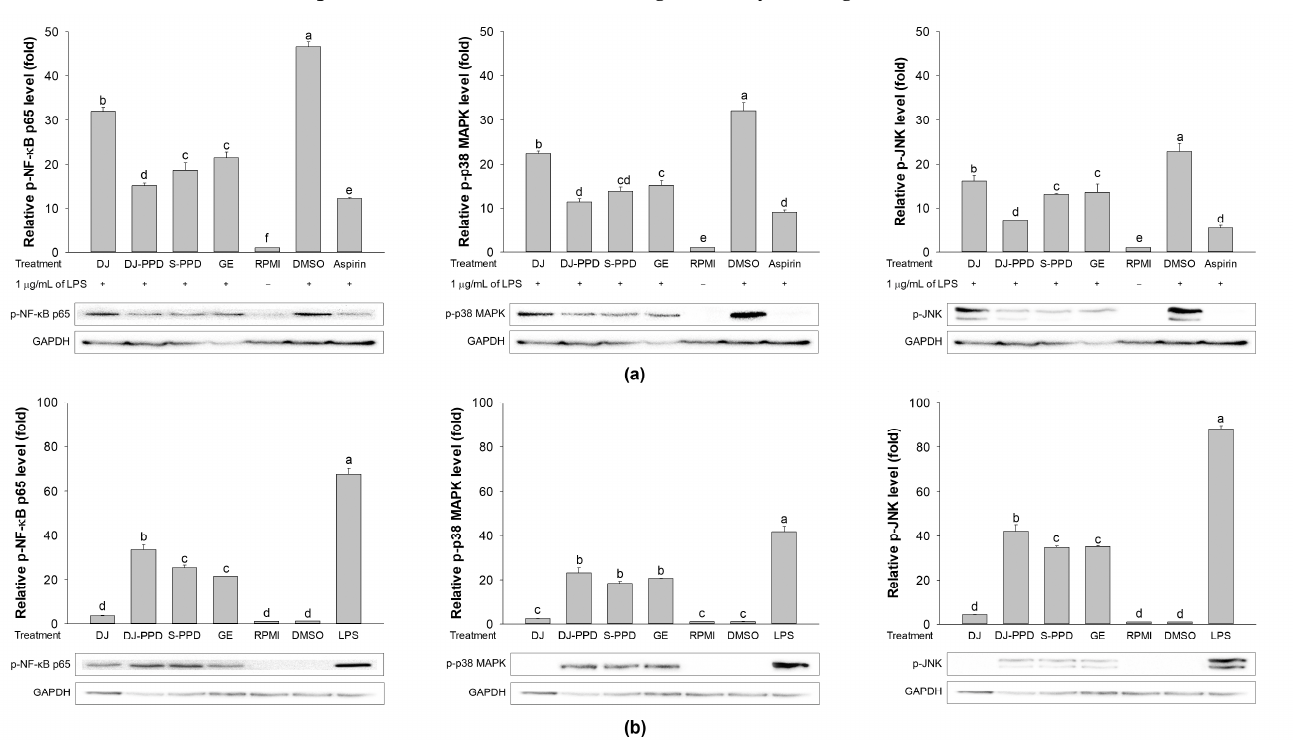
Figure 7. The immune-related pathway activation, ( a ) downregulation in cells pretreated with DJ extract, DJ-PPD extract, S-PPD, and GE extract, together with LPS stimulation, and ( b ) upregulation in cells pretreated with DJ extract, DJ-PPD extract, S-PPD, and GE extract. DJ, DJ-PPD, and GE con- centrations were 100 µg/mL, whereas the S-PPD concentration was 700 pg/mL. DMSO and LPS con- centrations were 0.1% and 1 µg/mL, respectively. Data are shown as means ± standard deviations. Lowercase letters indicate significant differences among treatments at p < 0.05.